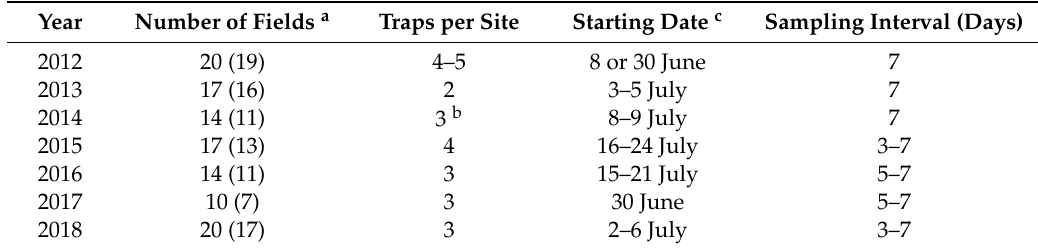
Table 1. Sampling frequency (number traps per field and trapping interval) for D. suzukii annual monitoring of adult relative